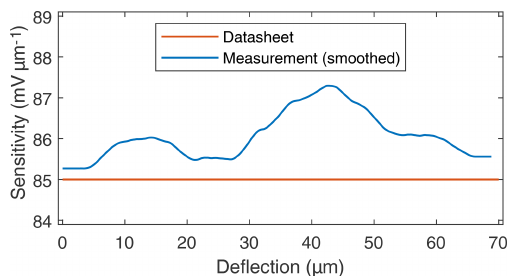
Figure 6. Sensitivity of the microprobe. Value given in datasheet (red) and measured values (blue).